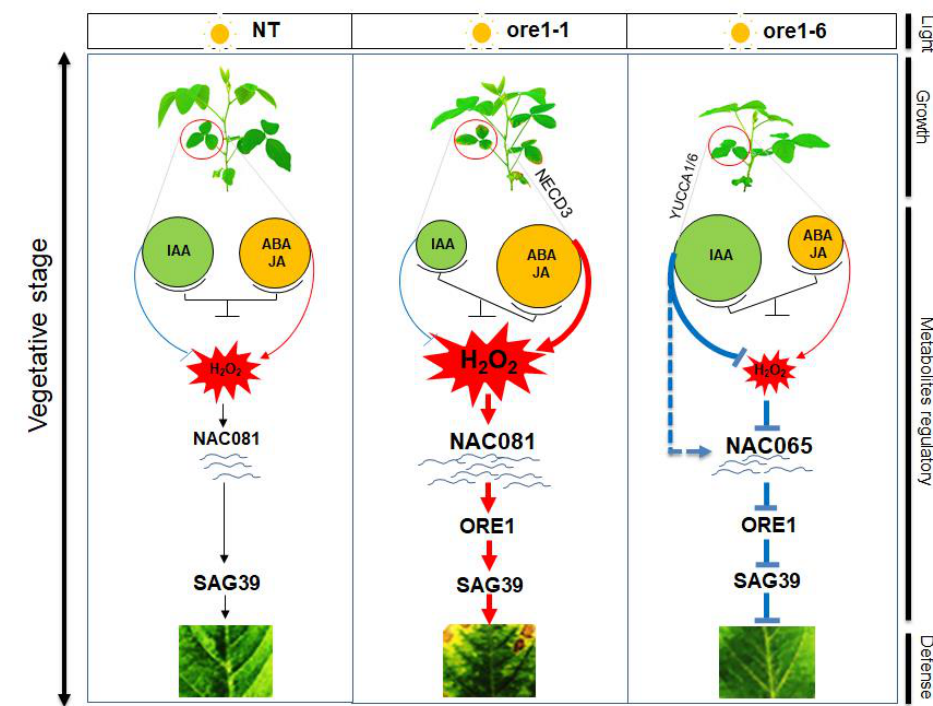
Figure 9. A proposed regulatory network model for the mechanism of action of ore1 -transgenic plants during slow leaf senescence in soybeans. The induced and repressed Atore1 gene identified in this study as well as the biological processes they are involved in hormone balance are shown together with the hormonal status, ROS, and transcription factors controlling the expression of the Atore1 gene. The red color indicates circuit responses to leaf senescence specific to ABA-mediated H 2 O 2 /NAC081 signaling. The green color represents the auxin-mediated NAC065 regulatory pathway in delayed leaf senescence. The thickness of the arrow expresses the strength of an induced or depressed response.